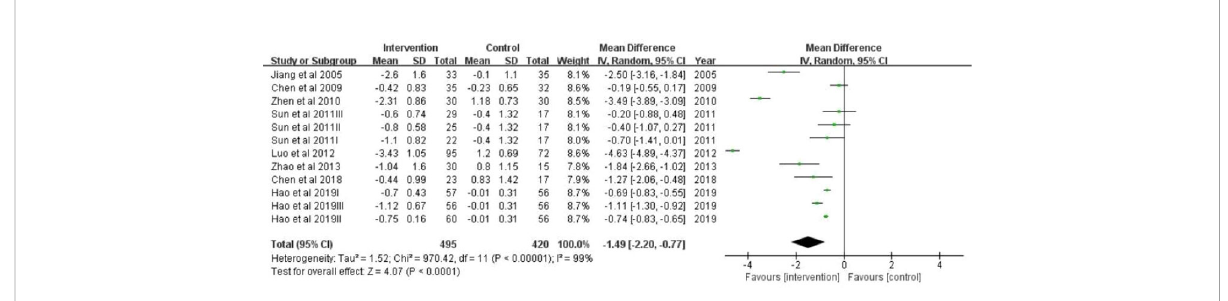
FIGURE 3 A forest plot providing data on the impact of lifestyle interventions on BMI with 95% con fi dence intervals of individual studies. Using a random effects model and an inverse variance method, a summary estimate of the 95% con fi dence interval was calculated. SD, standard deviation; IV, inverse variance; CI, con fi dence interval.